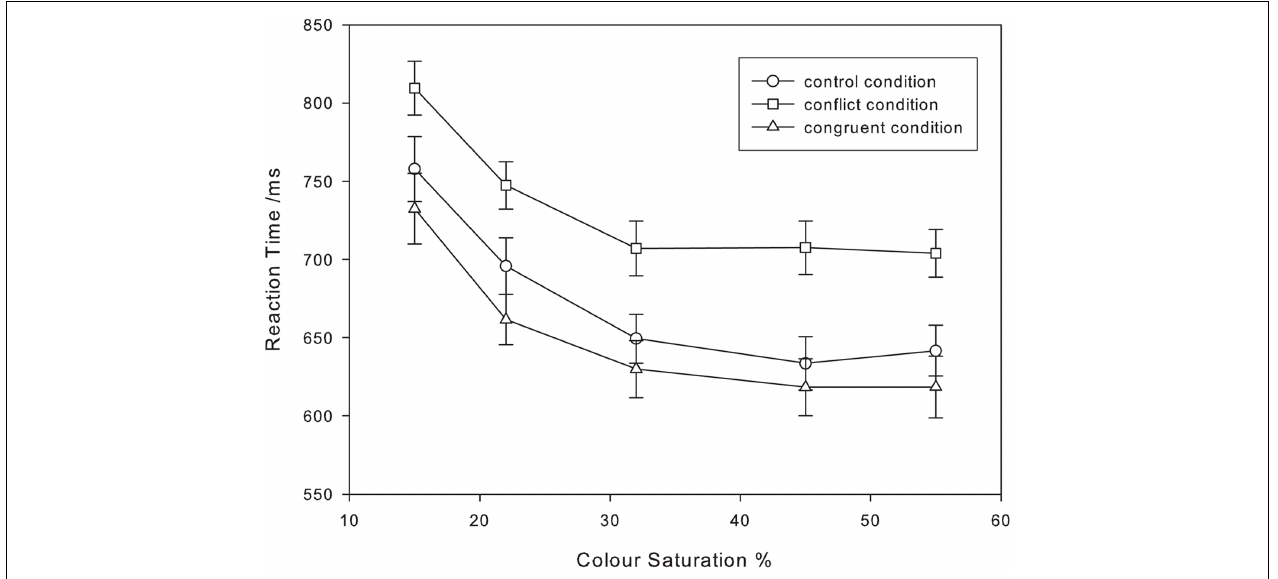
FIGURE 1 | Mean reaction times for different stimulus color saturations in all three Stroop conditions. SE bars shown ( n = 20). Data from experiment 1 of Stafford et al.